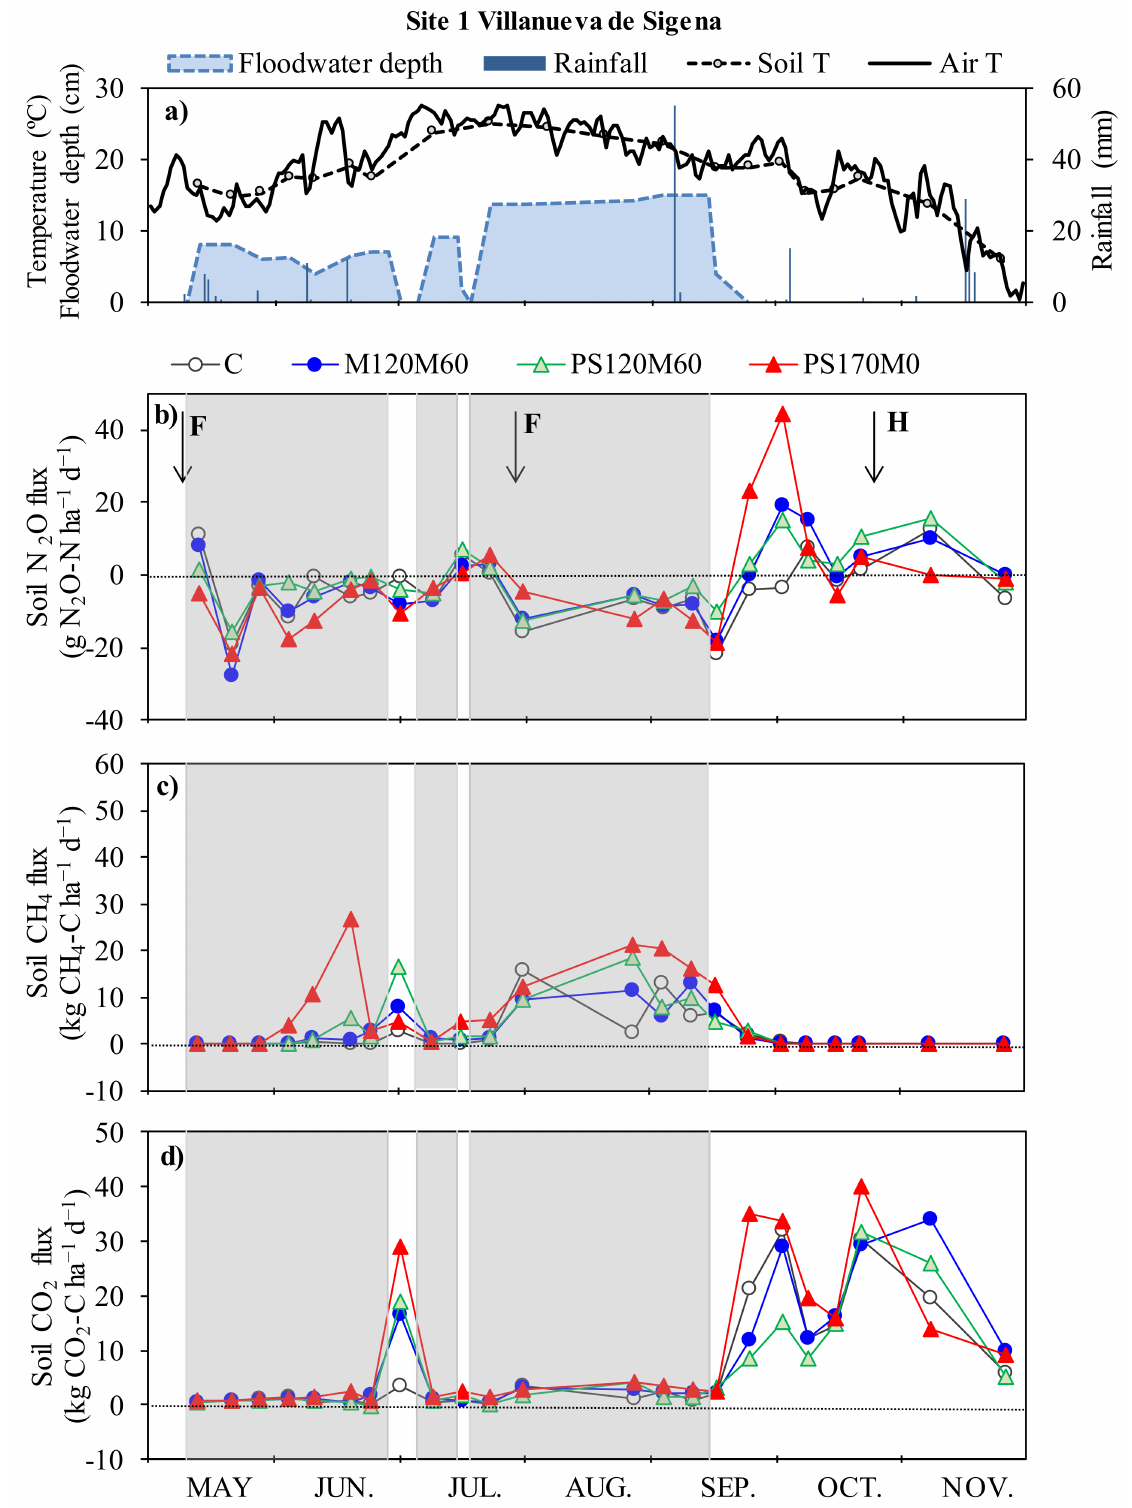
Figure 2. Site 1 (Villanueva de Sigena) year 2013. ( a ) Soil and air temperature, rainfall, and floodwater depth during the studied period; and ( b ) N 2 O, ( c ) CH 4 , and ( d ) CO 2 emissions as a ff ected by the fertilization treatment. Vertical arrows indicate the dates of fertilization applications (F) and harvest (H). The grey shaded areas represent the periods in which the water inflow to the field was open. Note that once water was stopped, the field remained flooded for several